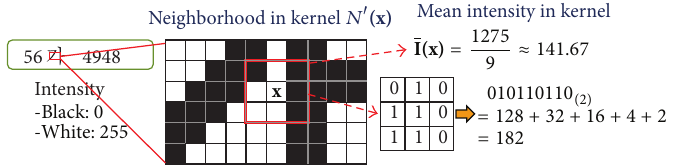
Figure 1: An example of the feature extraction of an image region in a vehicle license plate using MCT.